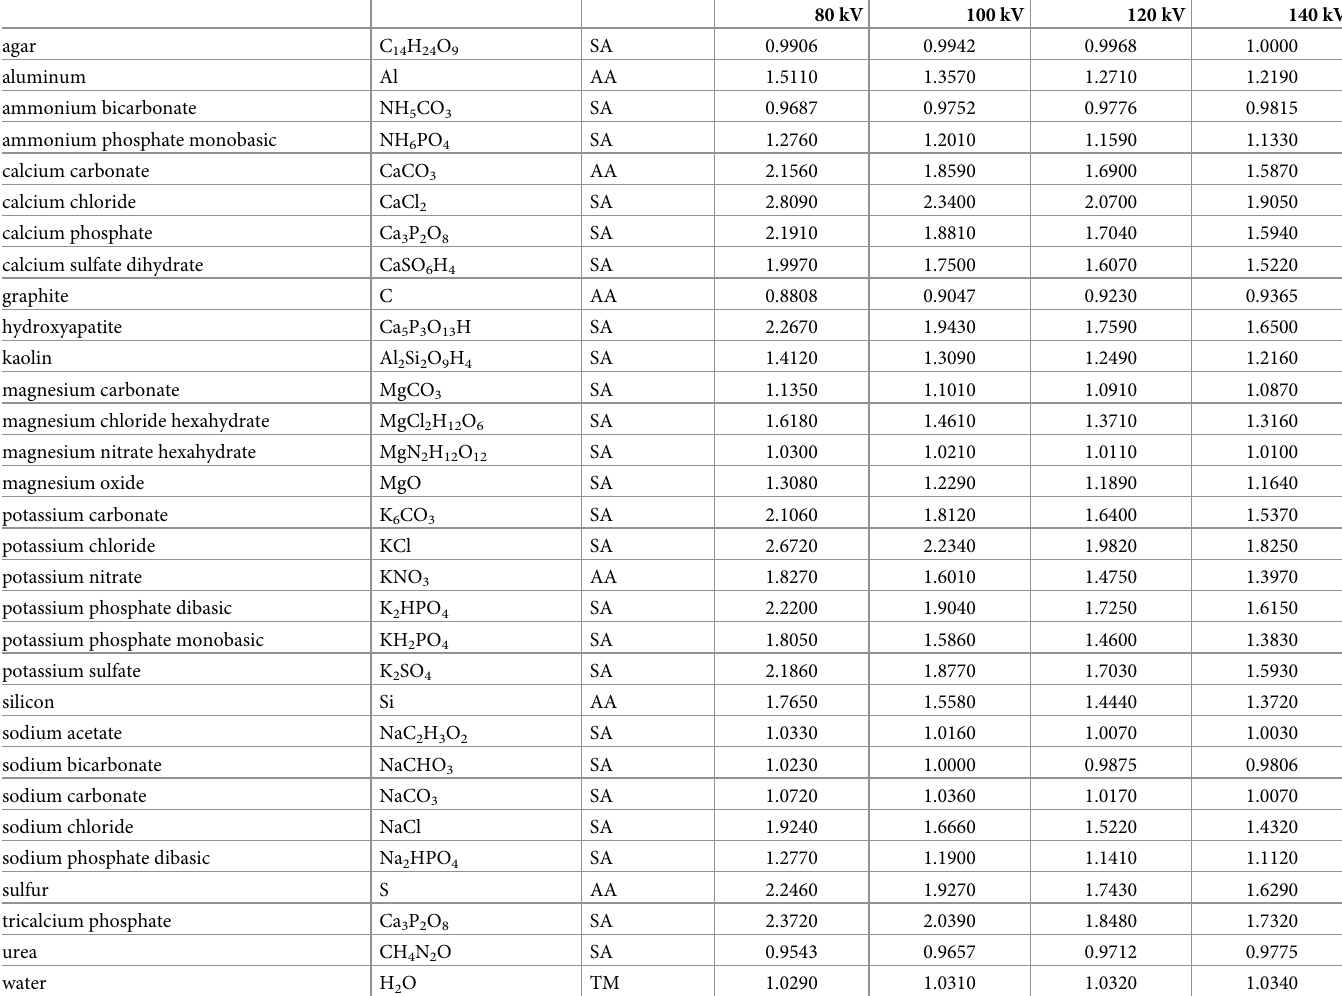
Table 1. The observed mass potency η ( ρ ) for the given compounds for each tube voltage. The initials refer to the supplier: AA (Alfa Aesar, Haverhill, MA, USA), SA (Sigma-Aldrich, St. Louis, MO, USA), and TM (NIST Thermodynamic Metrology Laboratory, Gaithersburg, MD,